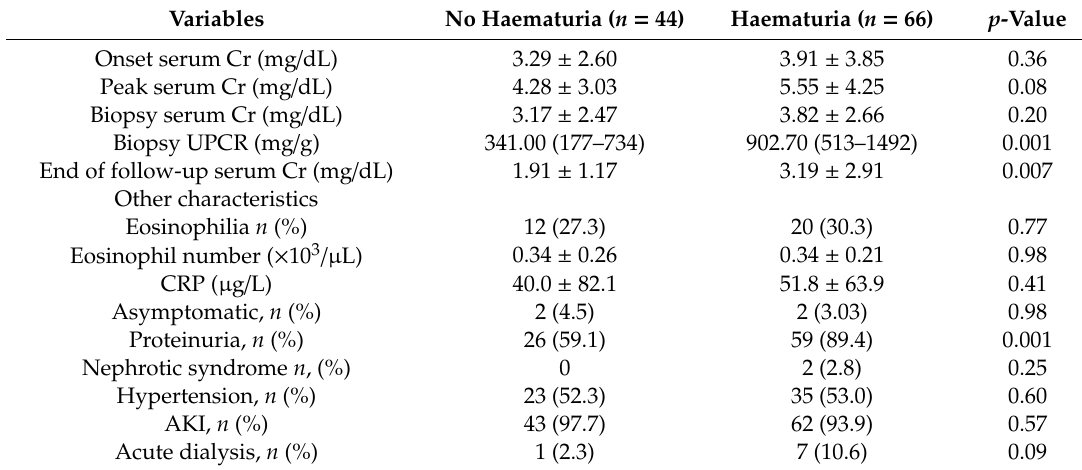
Table 2. Acute kidney injury secondary to ATIN according to the presence of haematuria.